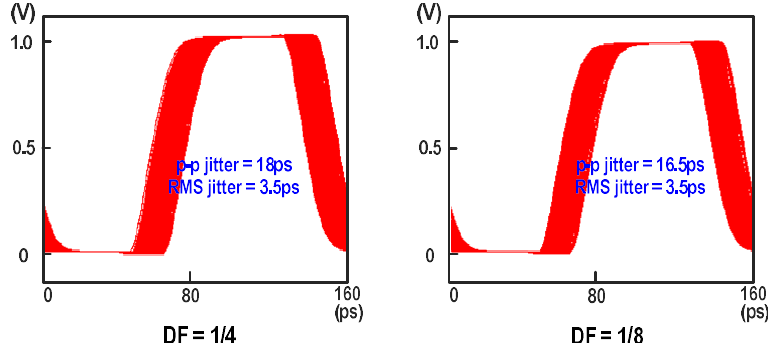
Figure 14. Post-layout simulation results of the recovered quarter-rate clock with decimation factor (DF) = 1/4 and 1/8.